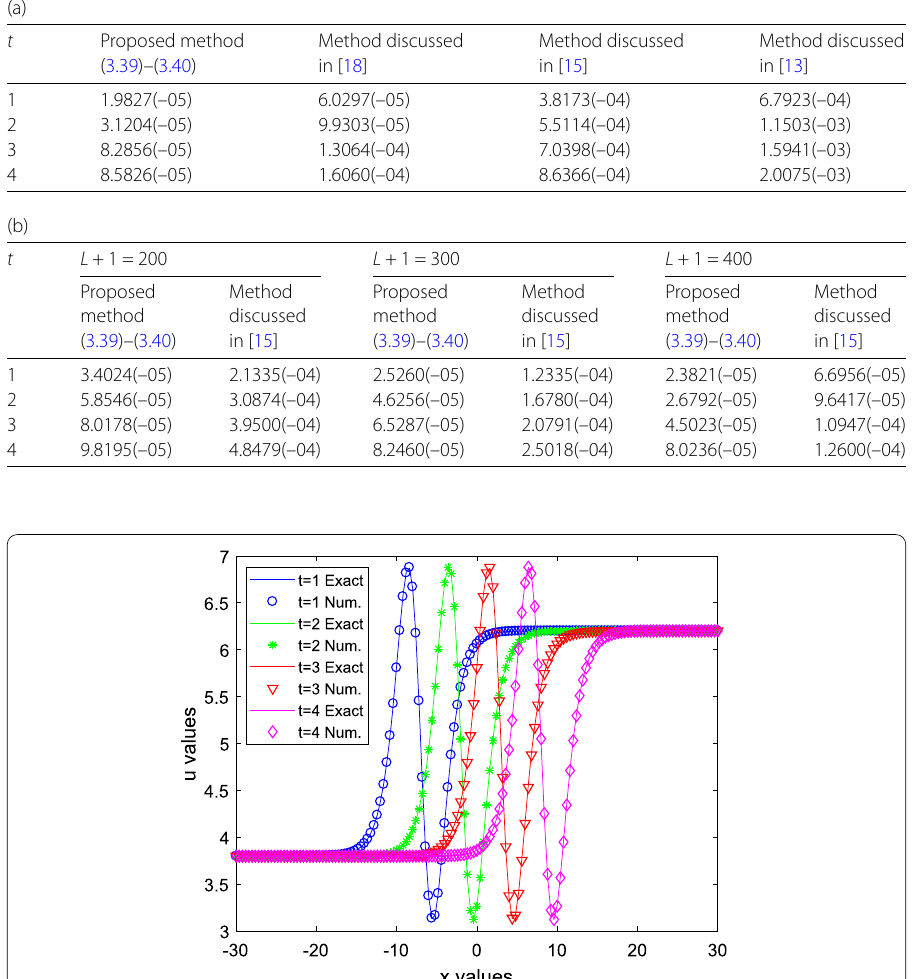
Table 1 Example 1: The global relative errors